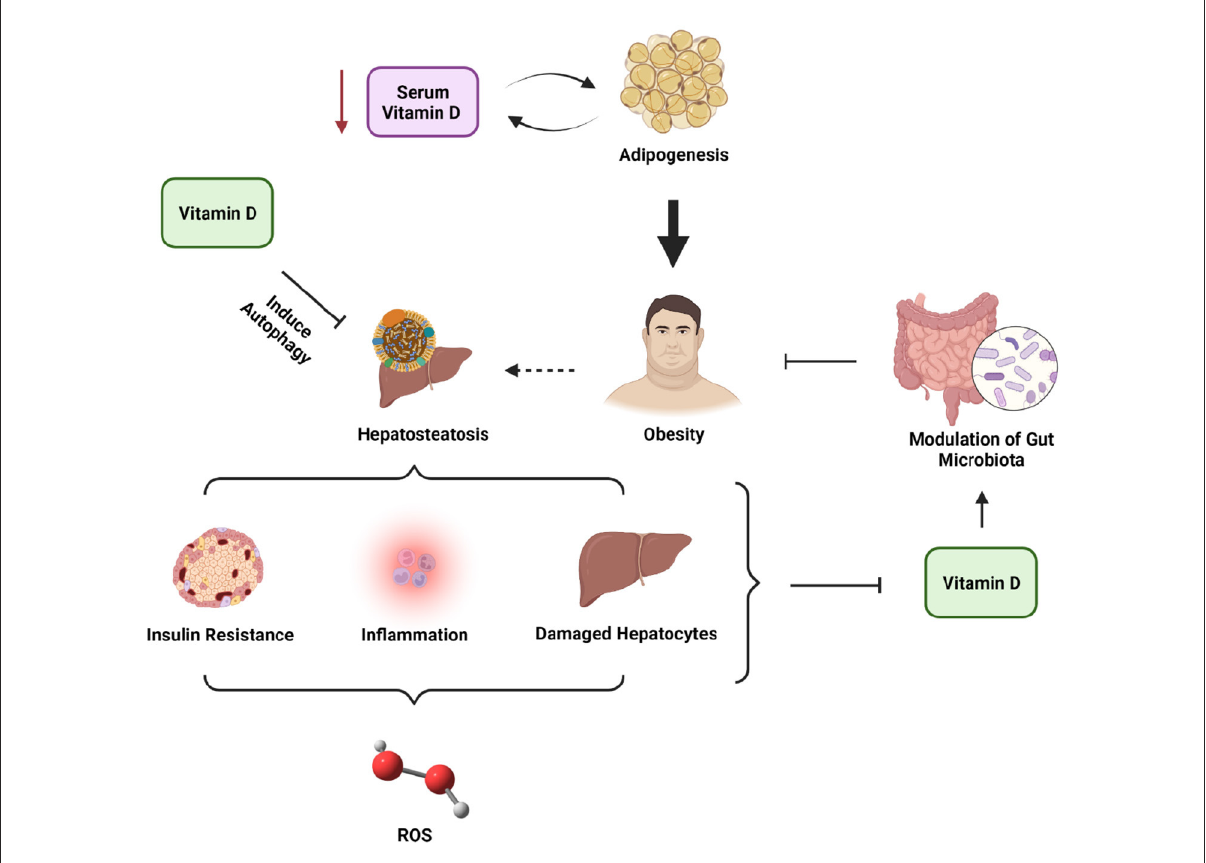
FIGURE1 The roles of vitamin D in NAFLD and